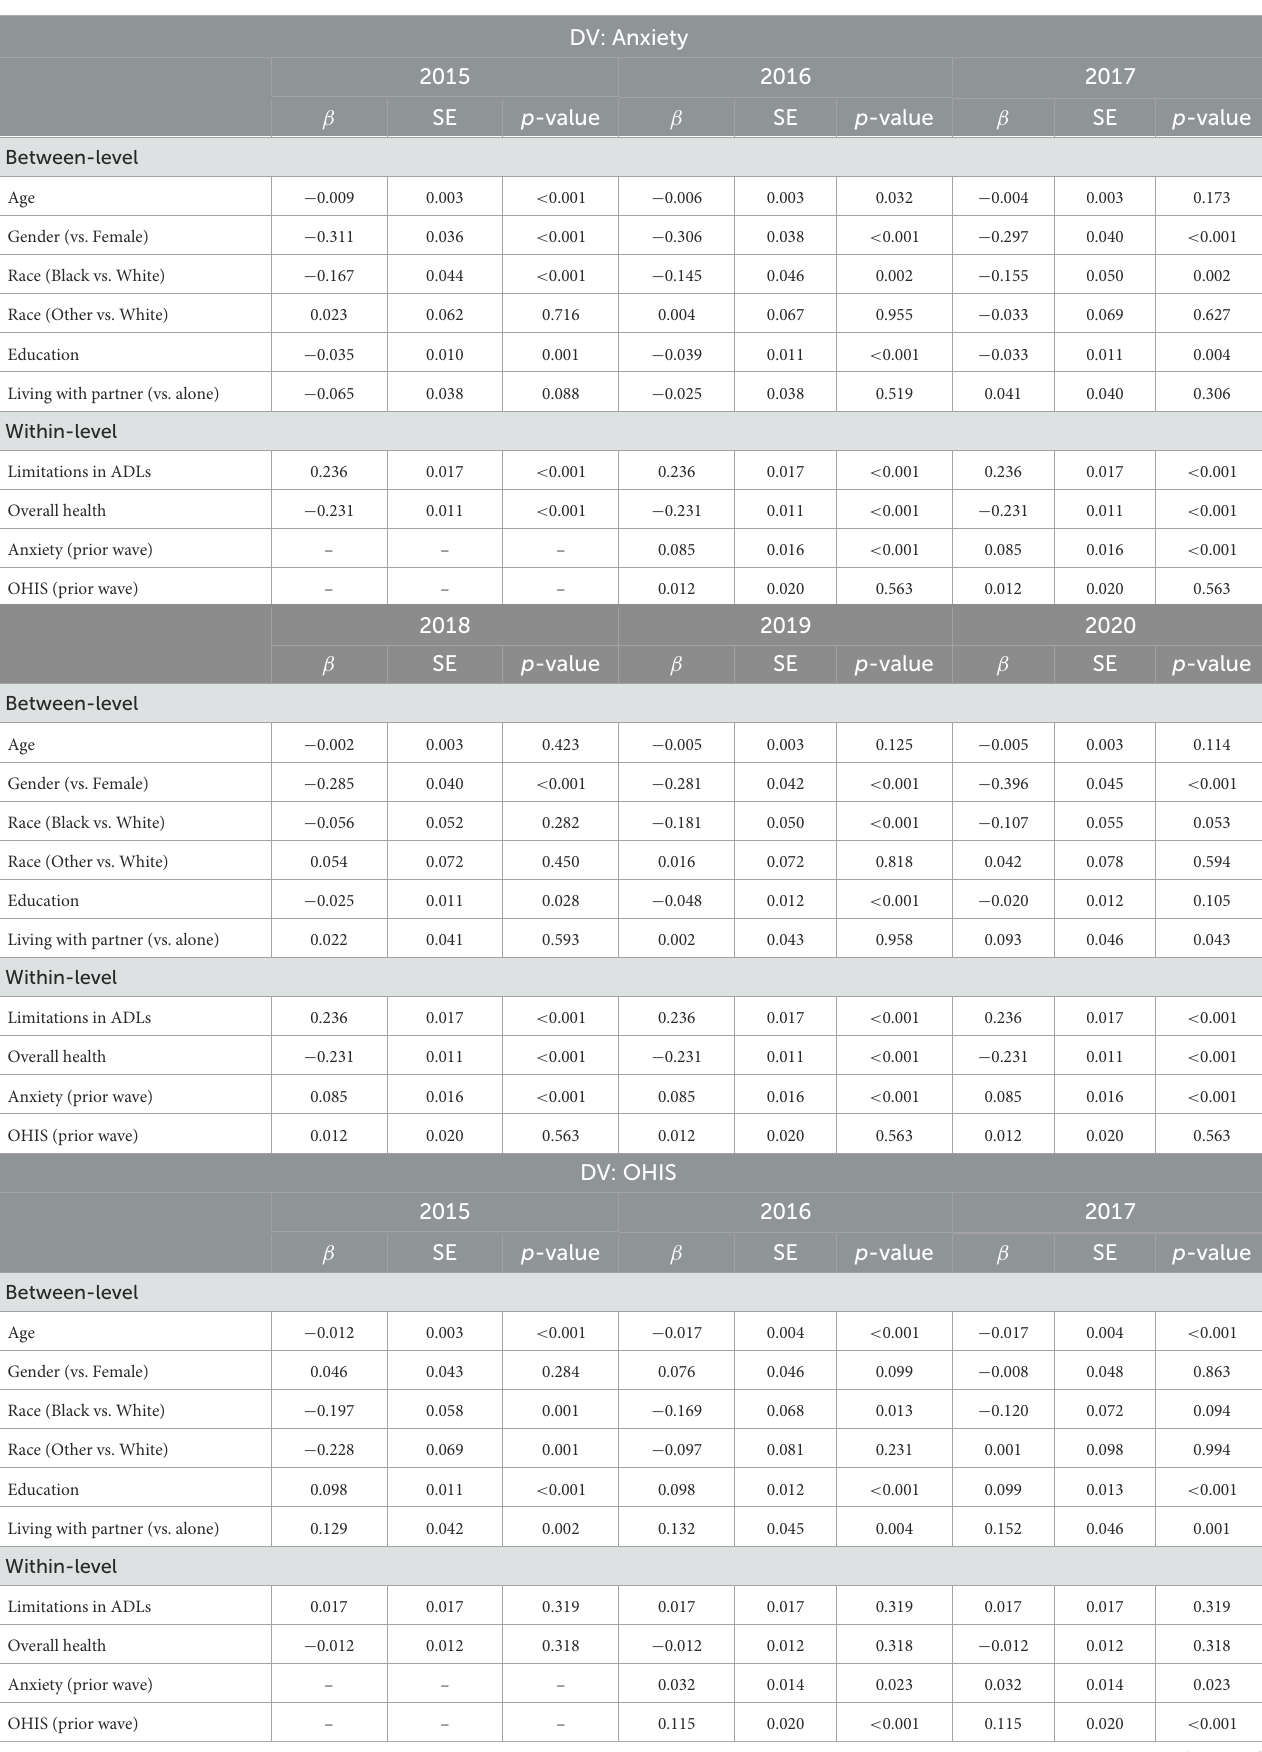
TABLE 2 The results of the